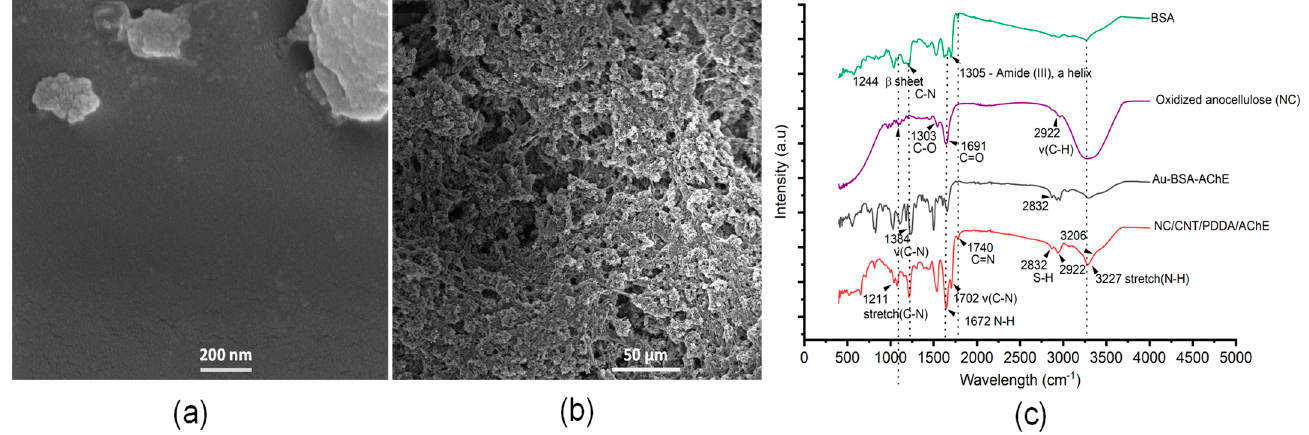
Figure 2. Surface characterization of the electrodes. Scanning electron microscope images of the ( a ) AchE/BSA-coated gold electrode and ( b ) AchE/MWCNT/PDDA/NC on the surface of gold electrodes. ( c ) FTIR spectra of organic elements on the electrode surface.